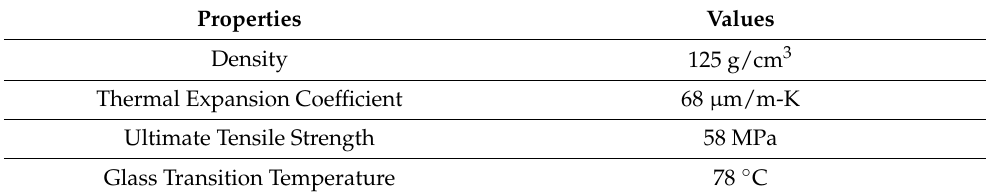
Table 1. Material Properties of Eco-ABS.